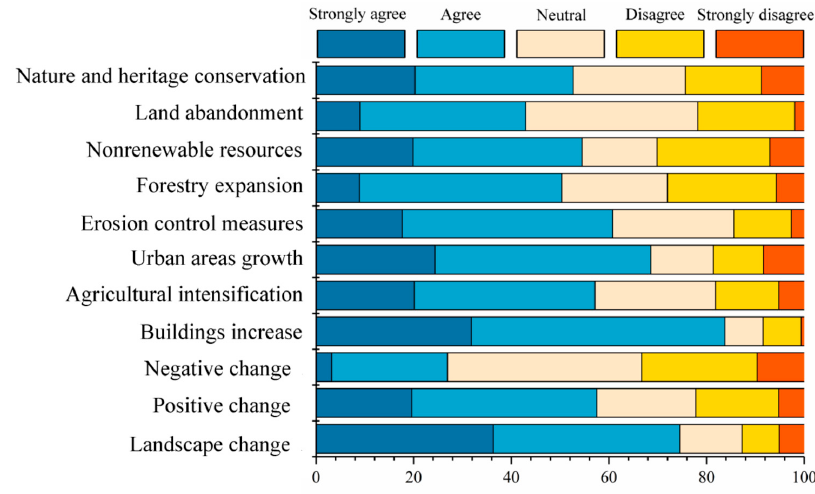
Figure 11. Landscape change perceptions by communities in the Nzhelele and Levuvhu river catchments.